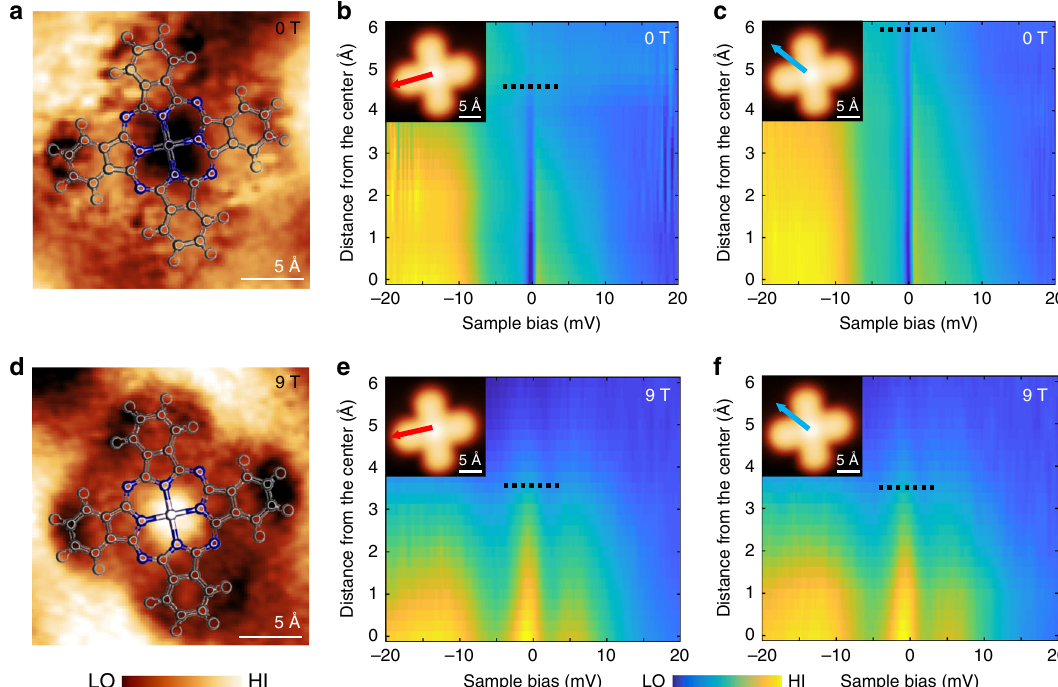
Fig. 3 Spatial distribution of the Kondo resonance at different magnetic fi elds. a d I /d V mapping taken around the Fermi energy at 0 T (setpoint: I = 0.3 nA, V = − 40 mV. Image size: 2.2 nm × 2.2 nm). b and c d I /d V spectra taken along different directions on the FePc molecule (as indicated by the arrows). The b spectra start from the Fe center and end at about 6 Å away. The black dashed line roughly indicates the position where the Kondo resonance is too weak to see in the d I /d V spectra. Inset: STM image (2.2 nm × 2.2 nm) of the FePc. d – f , same as a – c except taken at B = 9 T. The Kondo resonance (peak) displays a nearly circular spatial distribution in